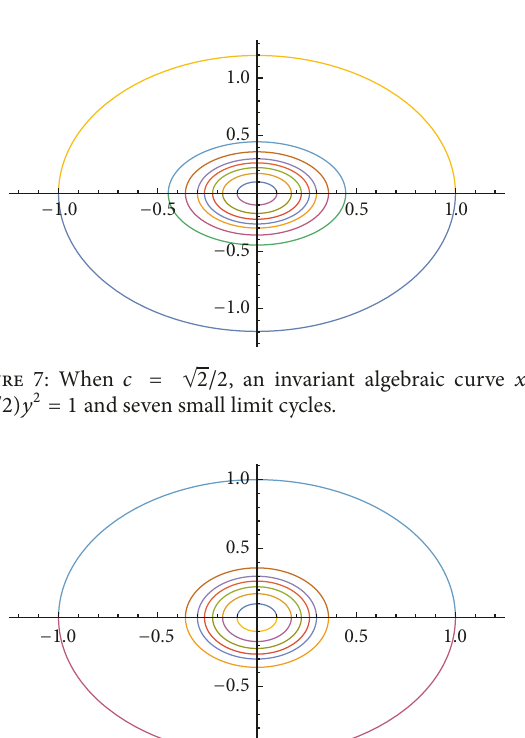
Figure 6: When 𝑐 = 0.581824 , an invariant algebraic curve 𝑥 2 + 0.581824𝑦 2 = 1 and eight small limit cycles.